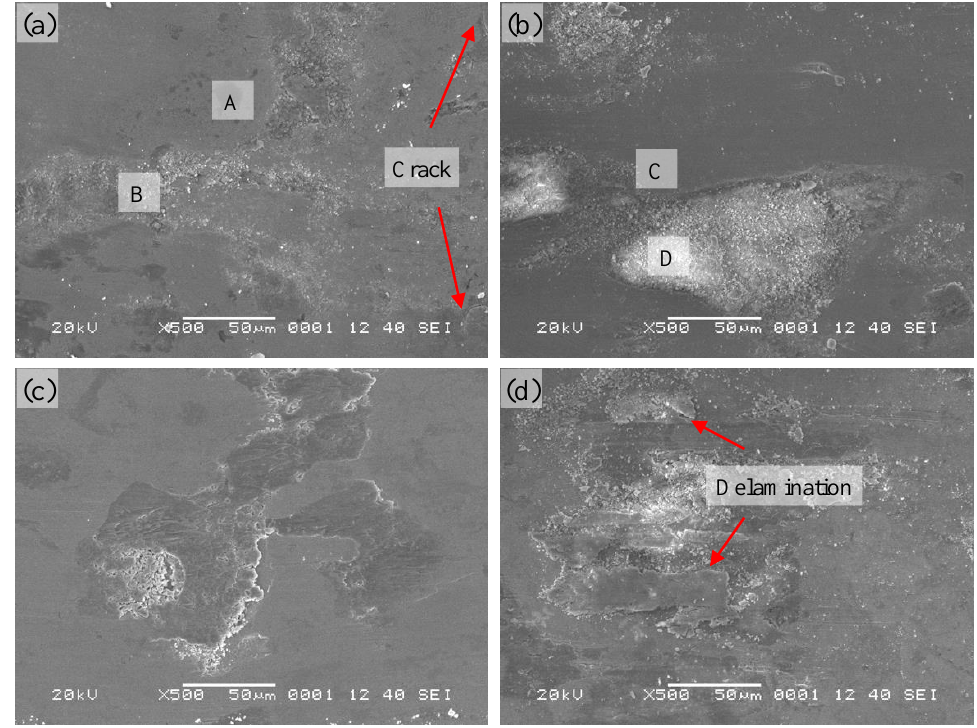
Figure 6. SEM micrographs of worn surfaces of Ni 3 Si alloy with 10% Ti addition at different Figure6. SEMmicrographsofwornsurfacesofNi 3 Sialloywith10%Tiadditionatdi ff erenttemperatures: ( a ) 25; ( b ) 200; ( c ) 400; ( d ) 600 ◦ temperatures: ( a ) 25; ( b ) 200; ( c ) 400; ( d ) 600 °C.